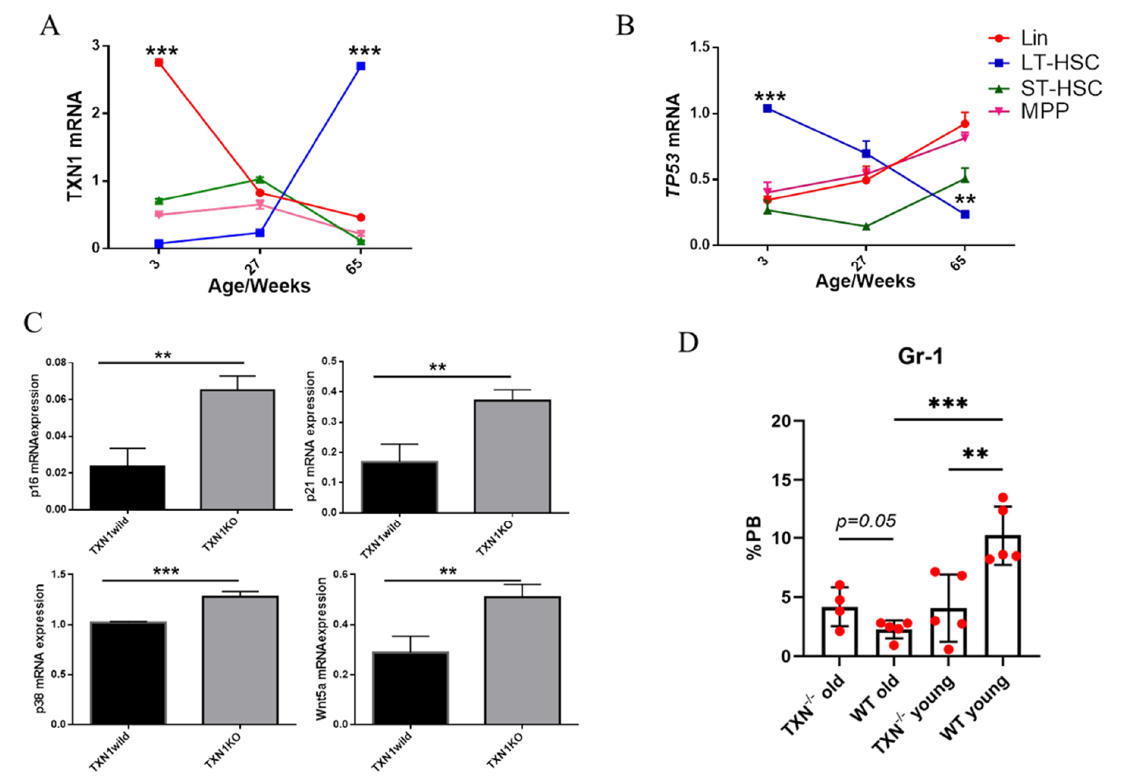
Figure 4. The loss of TXN1 enhances hematopoietic stem cells ageing: ( A , B ) Various hematopoietic cell populations from wild-type mice C57Bl/6 at 3, 27, and 65 weeks of age were sorted and measured for TXN1 ( A ) and TP53 ( B ). ( C ) BM Lin cells from the ROSA-ER-Cre-TXN fl/fl mice and controls were used to measure mRNA expression for Wnt5a, p21, p16, and p38. ( D ) The ROSA-ER-Cre-TXN fl/fl mice and controls at 2 months or 10 months were treated with tamoxifen, and at 10 days, peripheral leukocytes were measured. The data are represented as the mean ± SD. ** p < 0.01, *** p < 0.001.